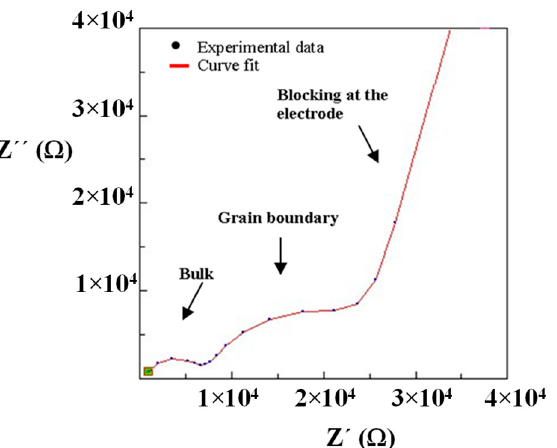
Figure 8. Impedance spectrum and curve fit of composite material (10% PEG/La 0.5 Li 0.5 TiO 3 ) ob- tained at − 20 °C.